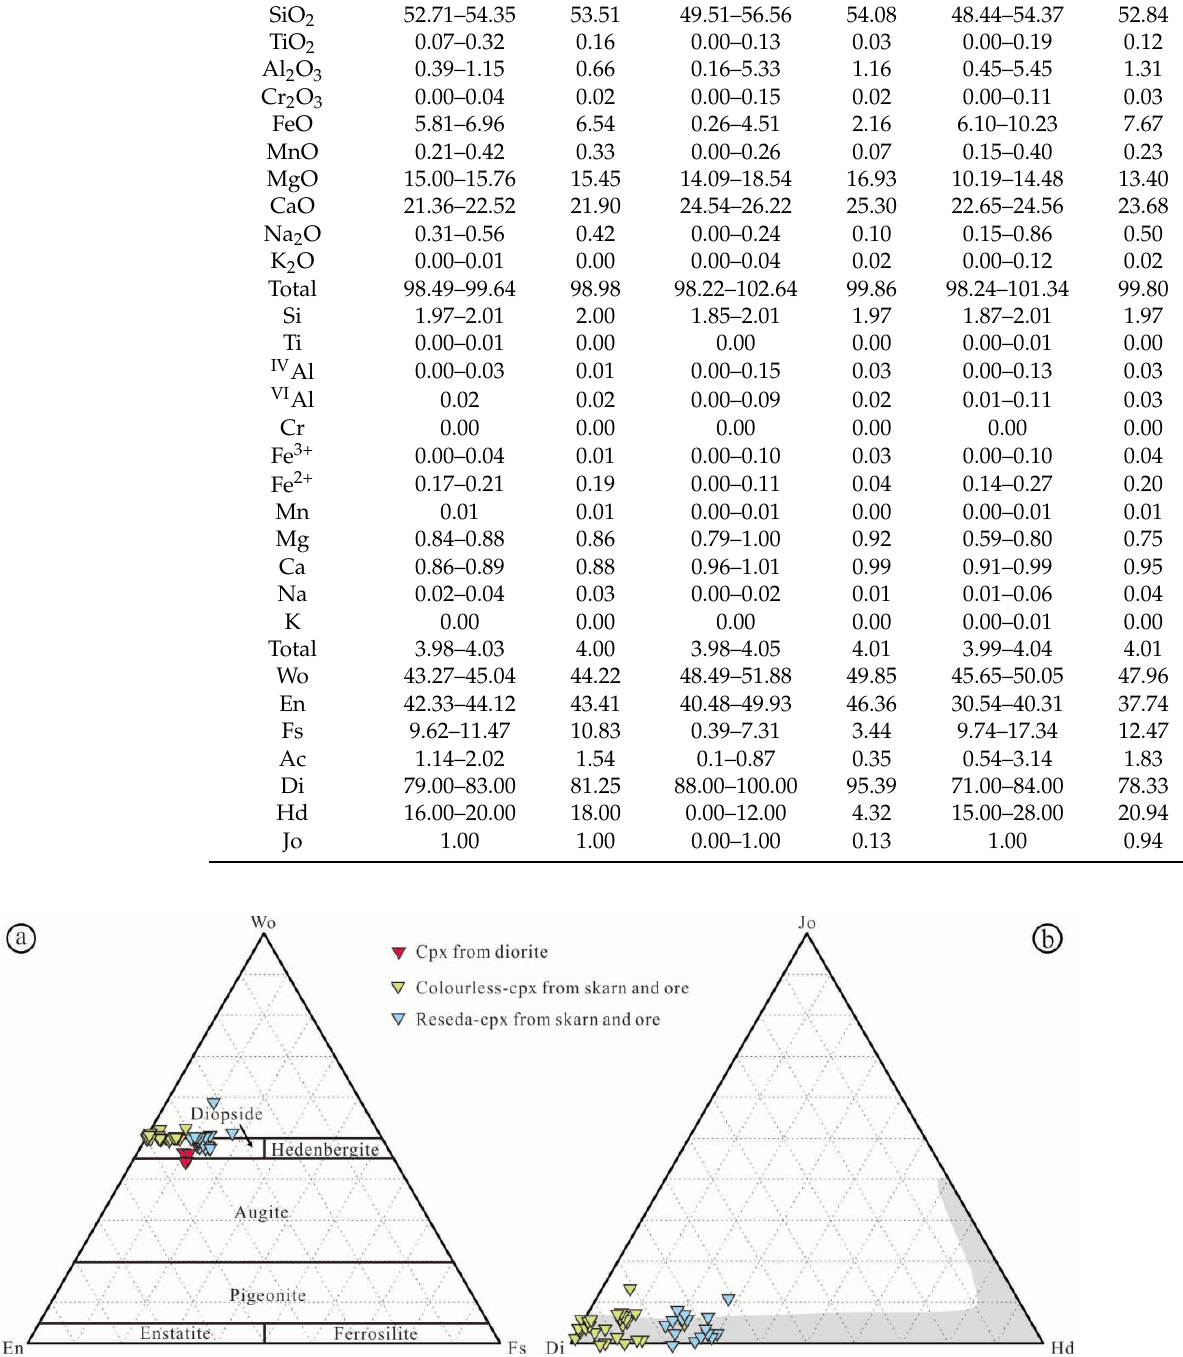
Figure 10. Classification diagram of clinopyroxenes from Jinling diorites, skarn, and ore ( a ), modified from Morimoto et al. [24]) and the compositional fields for garnet in Fe skarn deposits (Meinert et al. [25]) are shown in the diagram for comparison ( b ).